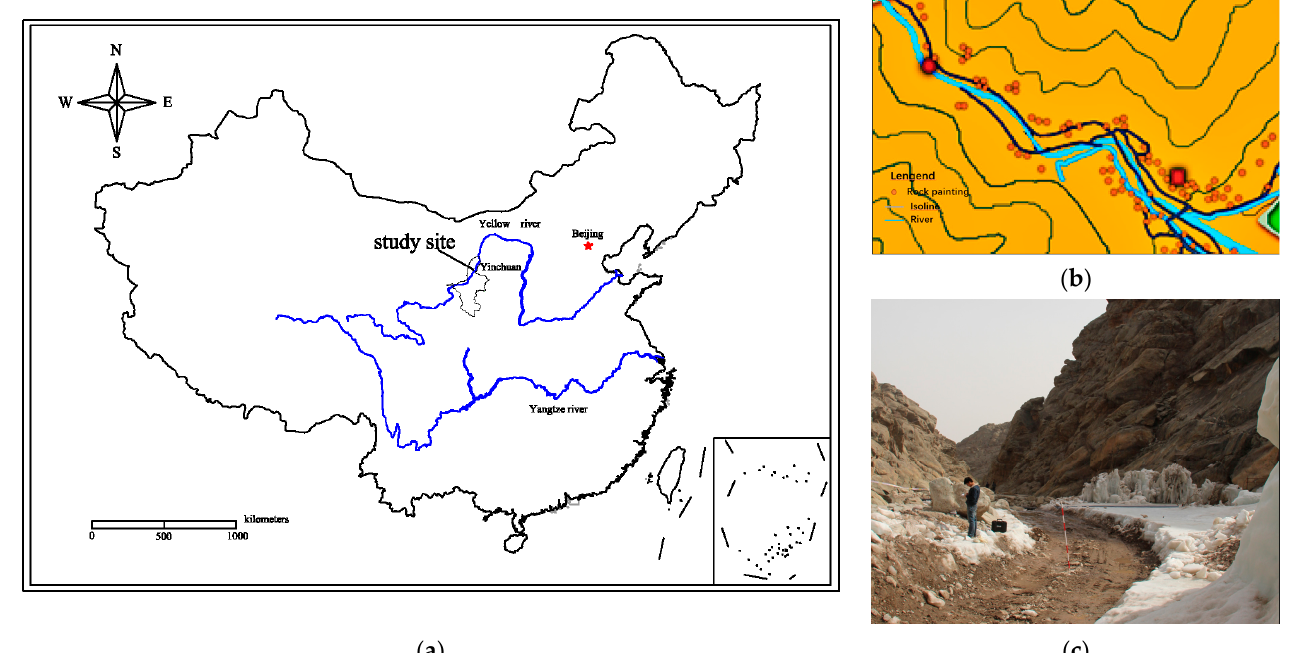
Figure 1. Location of the Helan Mountains petroglyphs: ( a ) the study site; ( b ) distribution of petroglyphs at study site; and ( c ) snow at study site.